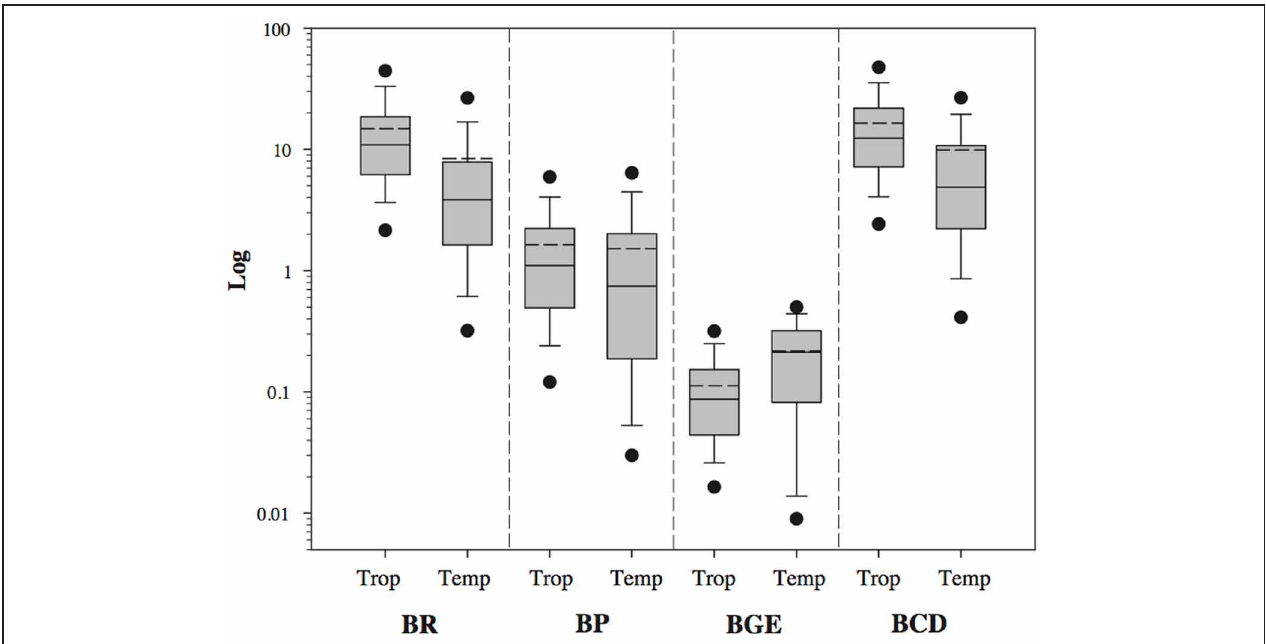
indicate the 10th and 90th percentiles, and the dots represent the 5th and 95th percentiles. Tropical and temperate data were significantly different (non-parametric Mann–Whitney Rank Sum test) in all the four variables (BP, BR, BGE and BCD with p < 0 . 001, see text for